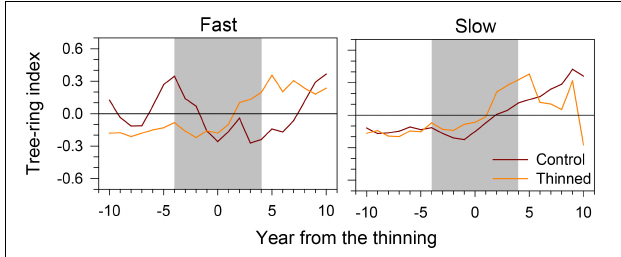
FIGURE 4 | Tree-ring index of fast- and slow-growing trees before and after thinning. Gray area represents the 8-year period considered by the successive